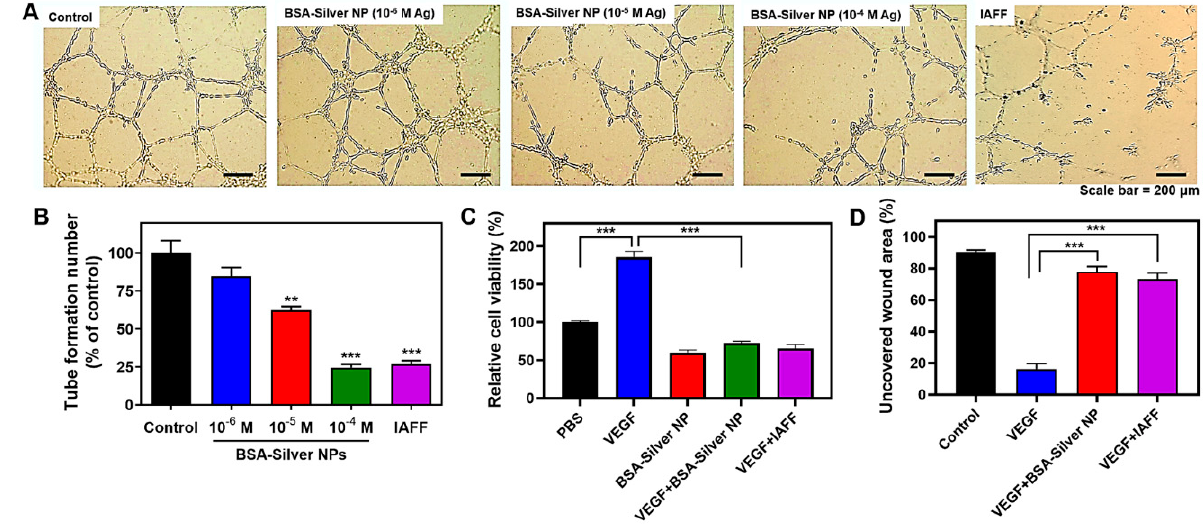
Figure 5. Anti-angiogenic activity of BSA-Silver NPs. ( A ) Representative images of HUVEC treated with BSA-Silver NPs or IAFF and ( B ) tubule numbers in the tube formation assay. ( C ) Cell proliferation and ( D ) cell migration assay results. The statistically significant differences were compared by one-way ANOVA (Tukey’s multiple comparison test as the post hoc test). ** p < 0.01, *** p < 0.001 vs. PBS control. (BSA-Silver NP: BSA-coated silver nanoparticles, HUVEC: human umbilical vein endothelial cells, IAFF: anti-insulin-like growth factor 1 receptor